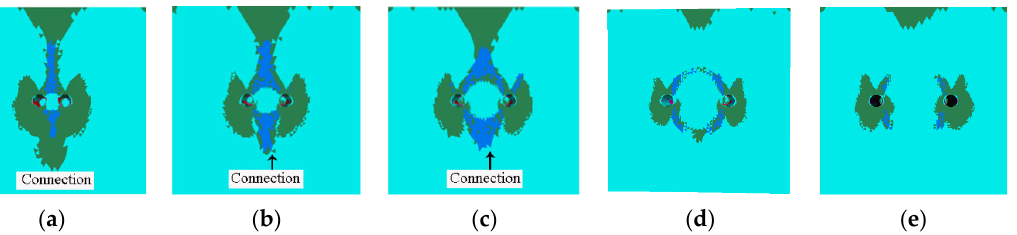
Figure 13. Failure diagram of specimens with different hole spacing. ( a ) 1 cm; ( b ) 2 cm; ( c ) 3 cm; ( d ) 4 cm; and ( e ) 5 cm.